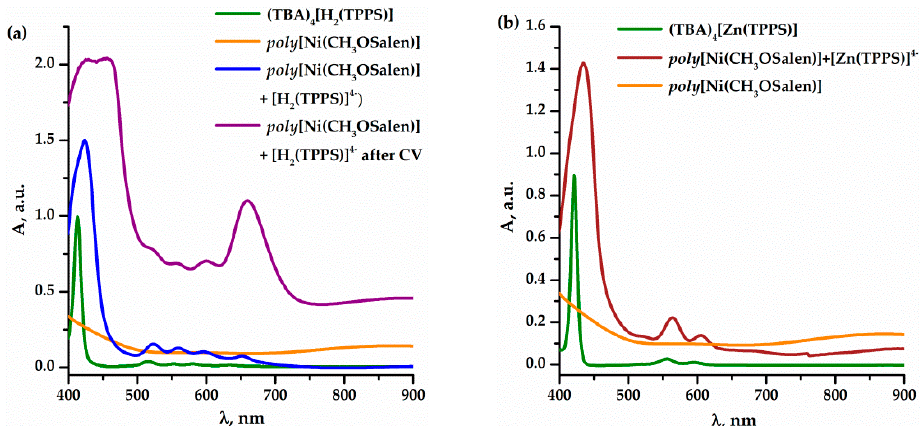
Figure 2. ( a ) UV-Vis spectra of 2 × 10 − 6 M [Bu 4 N] 4 [H 2 (TPPS)] aqueous solution, pristine poly [Ni(CH 3 OSalen)], poly [Ni(CH 3 OSalen)]:[H 2 (TPPS)] films and poly [Ni(CH 3 OSalen)]:[H 2 (TPPS)] film after CV experiments; ( b ) UV-Vis spectra of 2 × 10 − 6 M [Bu 4 N] 4 [Zn(TPPS)] aqueous solution, pristine poly [Ni(CH 3 OSalen)] and poly [Ni(CH 3 OSalen)]:[Zn(TPPS)] films.